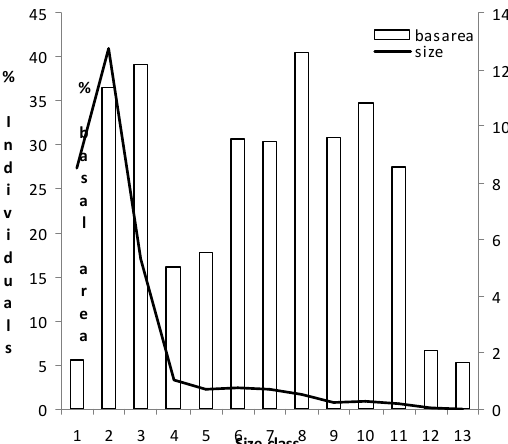
Fig. 2. Size class distribution of individuals and basal area in Kagekanu permanent vegetation plot